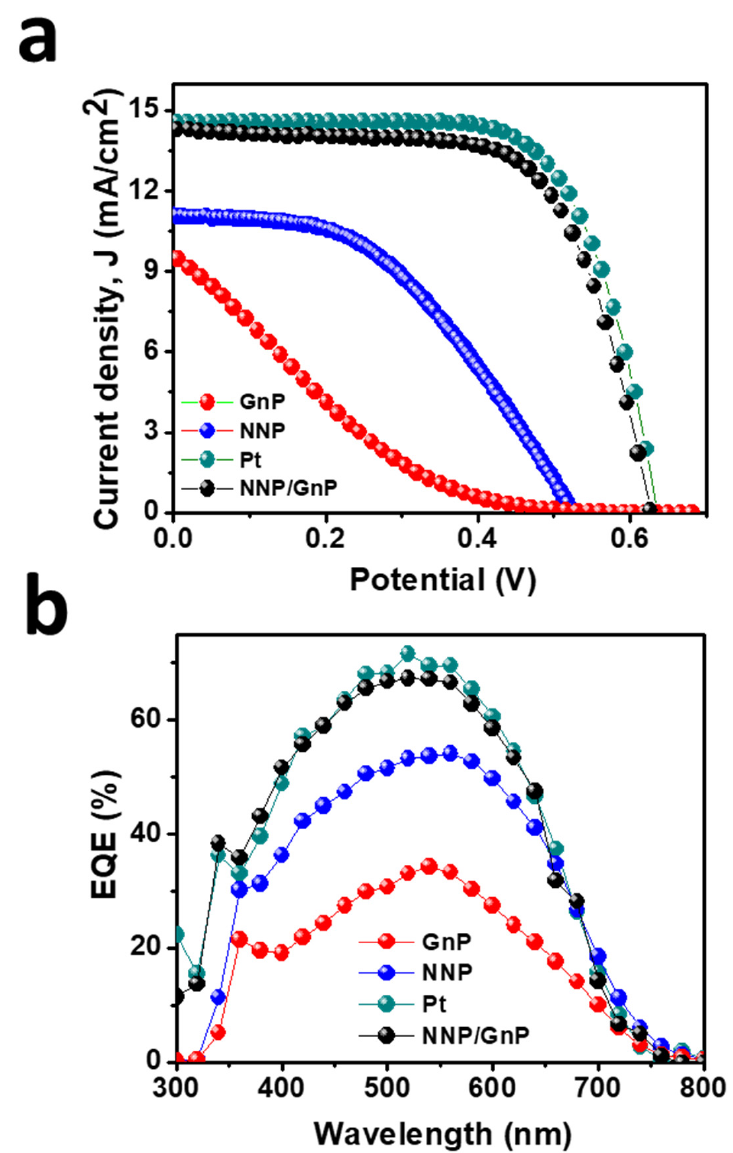
Figure 6. ( a )Photocurrent density ( J )-voltage ( V ) plot of DSSCs based on different CEs and ( b ) their corresponding IPCE spectra. Table 2. Photocurrent density ( J )–voltage ( V ) parameters of DSSCs based on different counter electrodes with the corresponding EIS parameters of the cells.